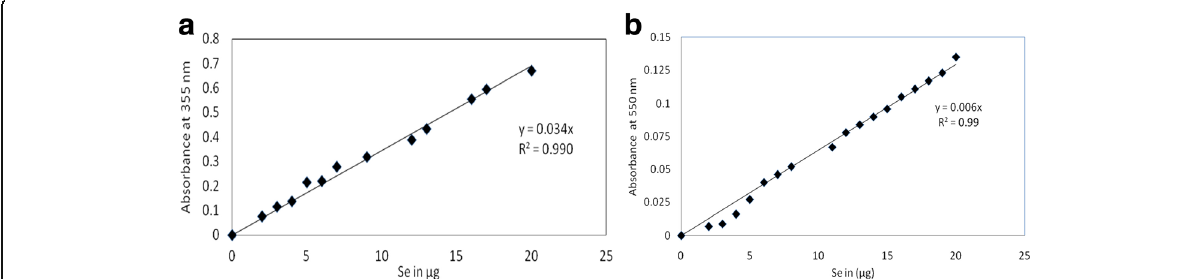
Fig. 3 a Absorbance value of I 3 − loaded films as a function of concentration of Se (IV) in aqueous solution. b Calibration curve for variamine blue-oxidized sensor, absorbance recorded at 550 nm. [ 1 μ g mL − 1 Se (IV), 1 mL 2% KI and 1 mL 2 M HCl, 3 mL variamine blue dye solution (8×10 − 5 M) and 2 mL 1 M